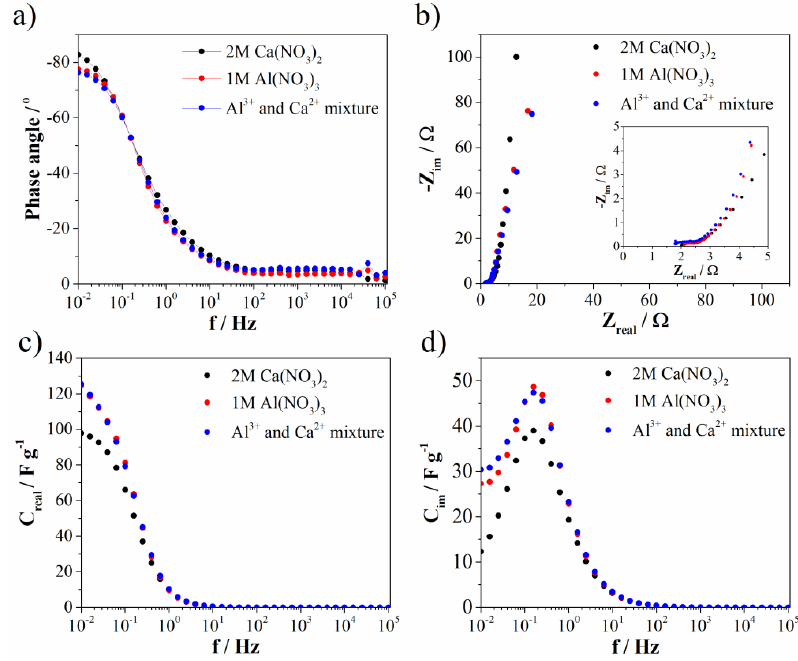
Figure 10. ( a ) Bode, ( b ) Nyquist plot, and ( c , d ) complex capacitance analysis.